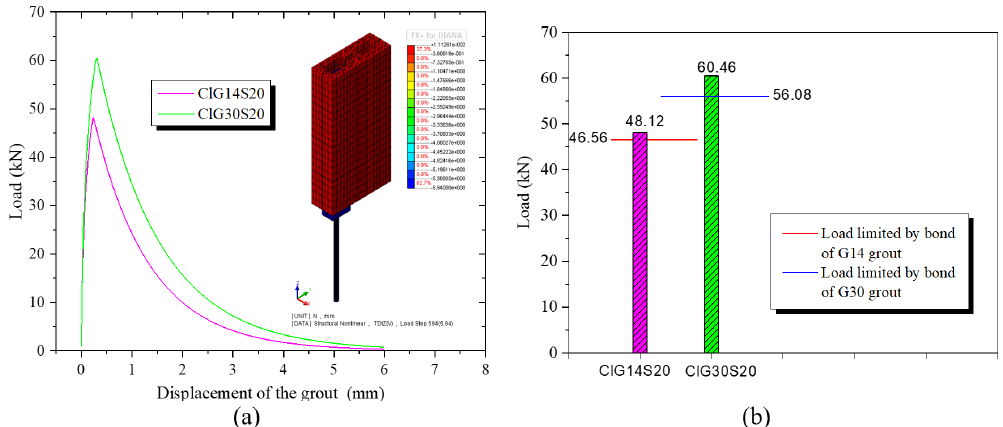
Figure 18. Pull-out tests with rebar diameters of Ø20 mm (a) parametric results (load vs displacement diagrams) and (b) maximum